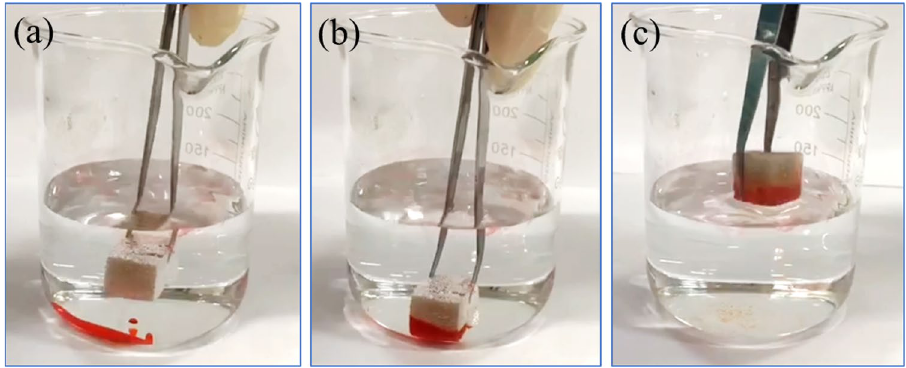
Figure 15. Tetrachloromethane dyed with Sudan III was absorbed by OTS-PDA-MS when injected at the bottom of the beaker.